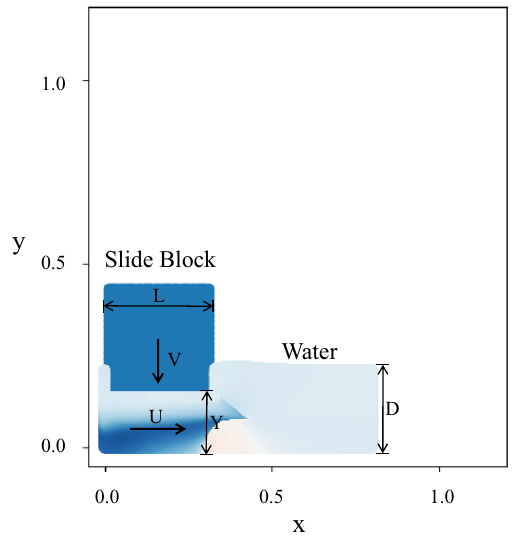
Fig. 1 Schematic diagram of the landslide surge model